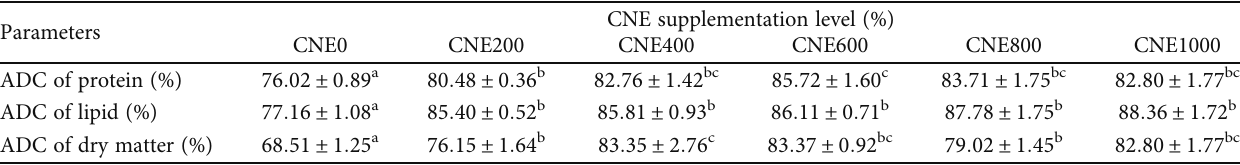
Table 6: Apparent digestibility coe ffi cient (ADC) of juvenile H . otakii fed the experimental diets for 8 weeks.